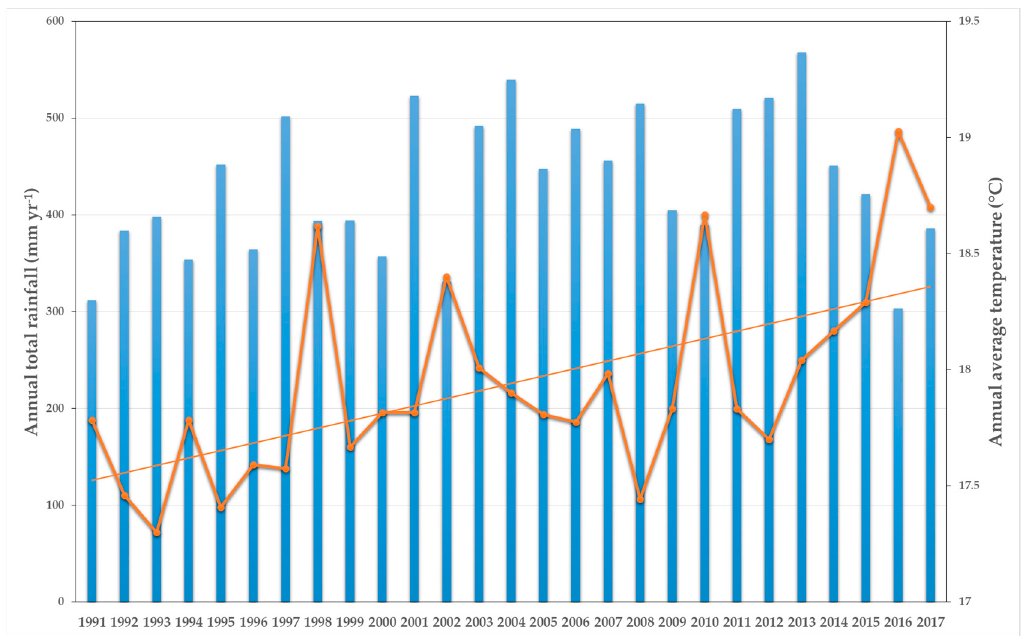
Figure 3. Total rainfall (blue bars) and mean temperature (dots between orange lines and fitted least-square line for the total period) in the Rocha River catchment in each year between 1991 and 2017.